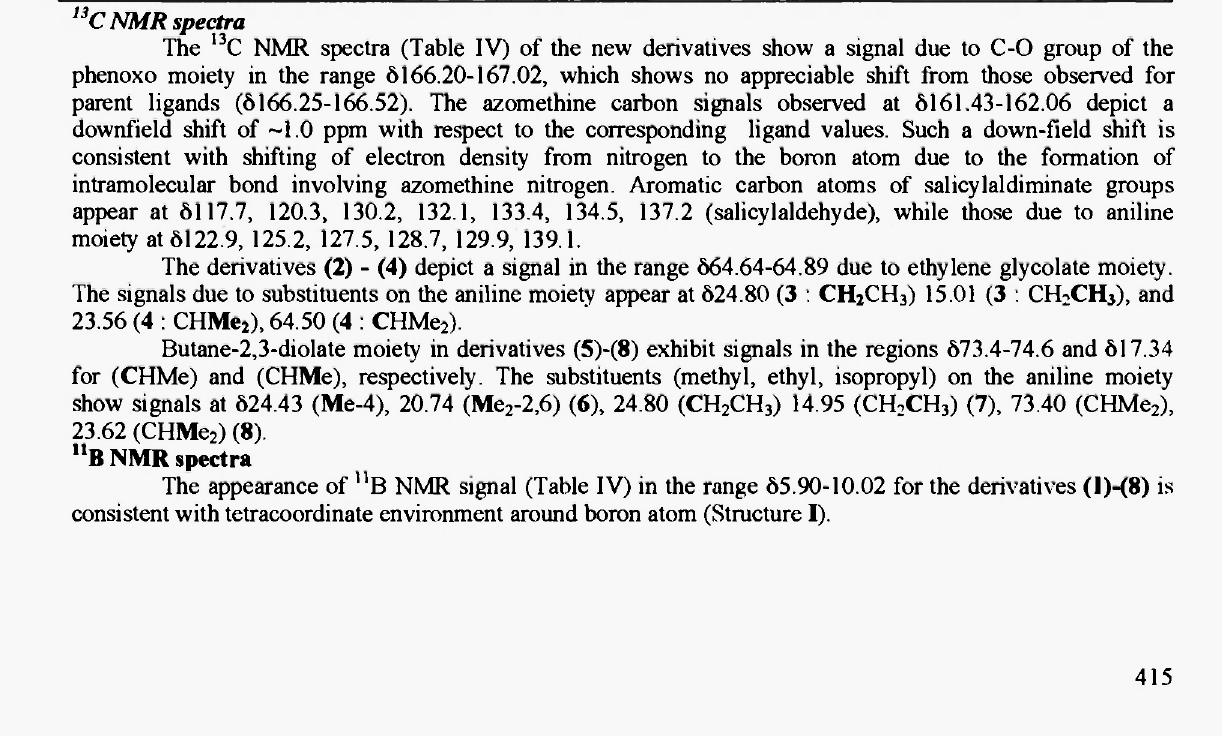
Table III.'Η and "B NMR Data (5, ppm)for Salicylaldiminate Derivatives of Boron(l)-(8)